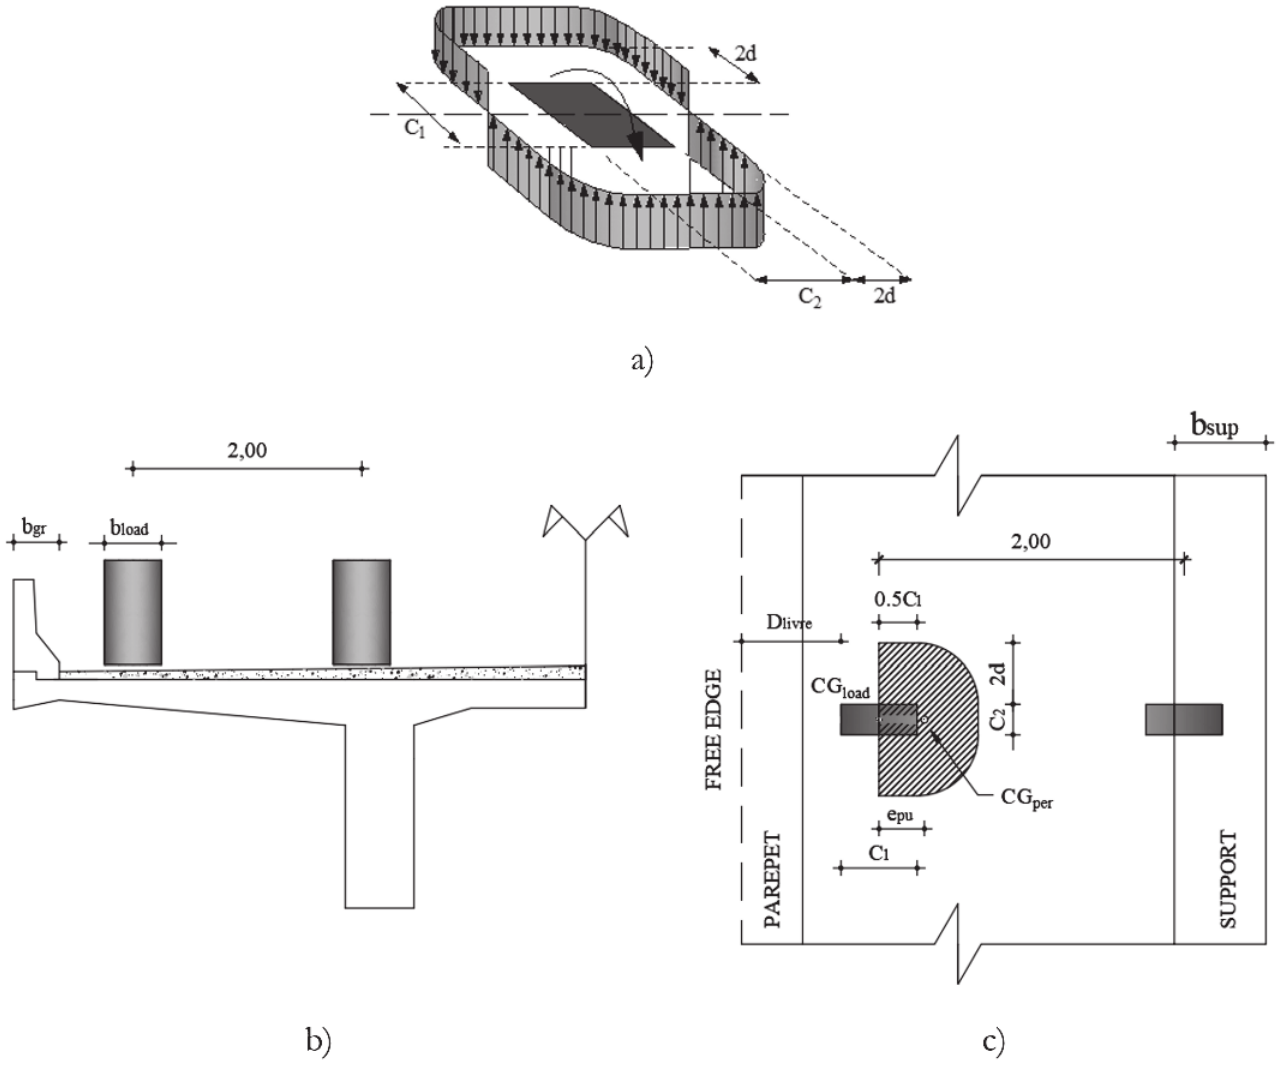
a) Distribution of shear force due to unbalanced moment in a slab-column connection (adapted from Eurocode 2 [18]), b) cross section of a cantilever slab bridge and c) example of eccentricity determination between the loaded area and the punching perimeter (top